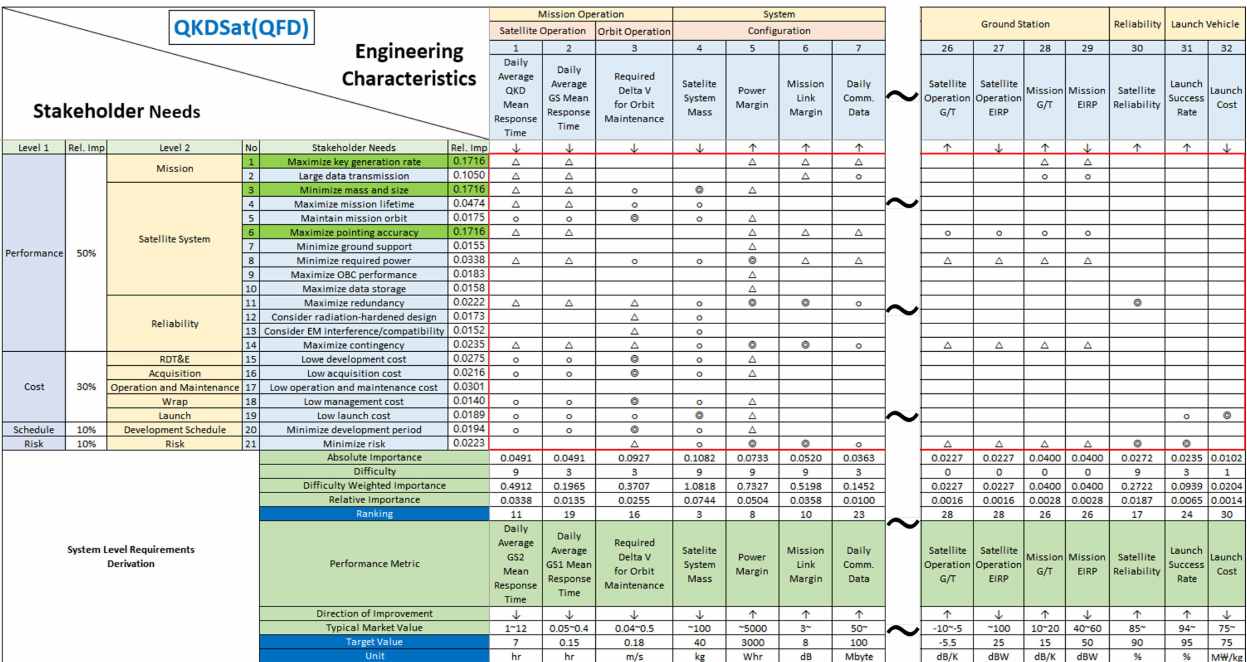
Figure 6. Final QFD results (only parts of the results are